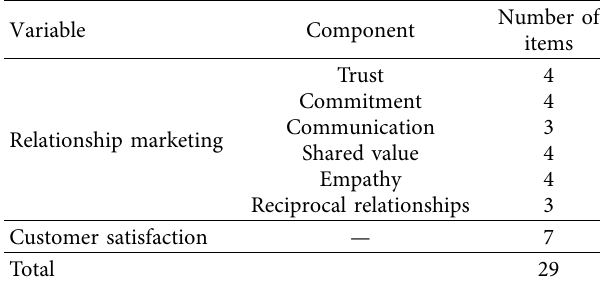
Table 1: Number of variables and items of the questionnaire.